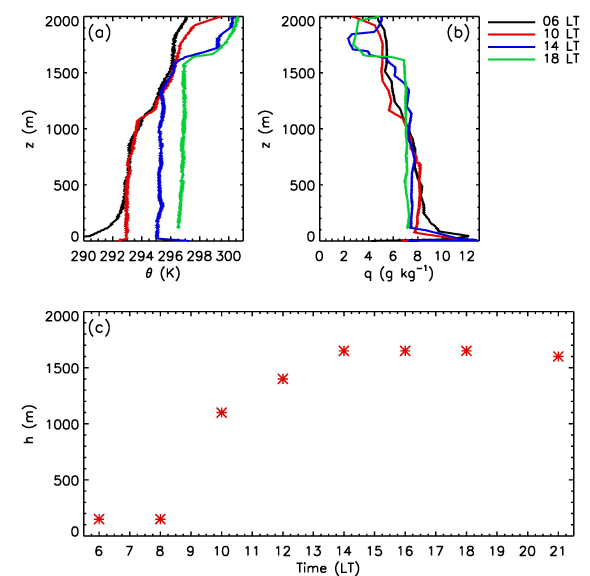
Fig. 4. (a) and (b) Evolution of the vertical profiles of potential tem- perature and specific humidity measured the 6 August 2010 (06:00, 10:00, 14:00 and 18:00LT). (c) Estimation of the boundary layer height evolution calculated from the vertical profile